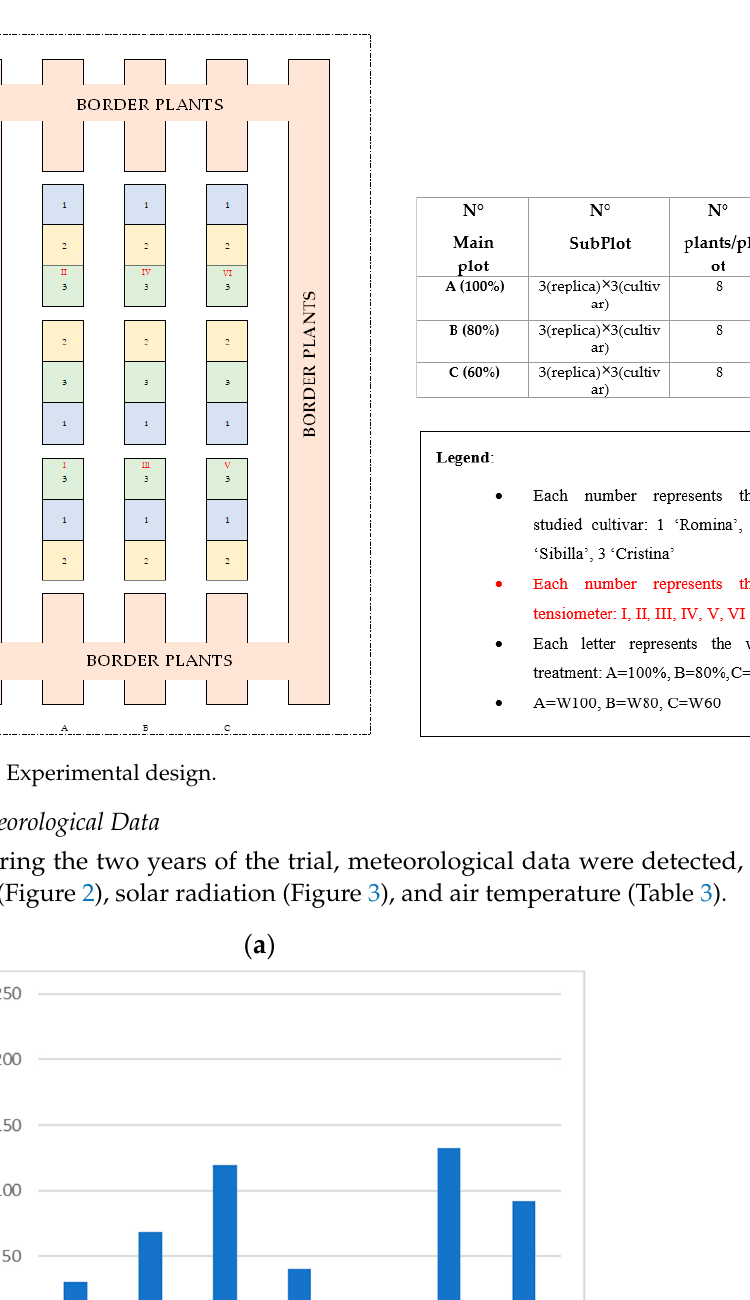
Figure 2. ( a ) Rainfall data of 1-year test: 264.2 mm of rain from August 2016 to December 2016; 213.8 mm from January 2017 to February 2017. ( b ) Rainfall data of 2-year test: 448 mm of rain from August 2017 to December 2017; 69 mm from January 2018 to February 2018.